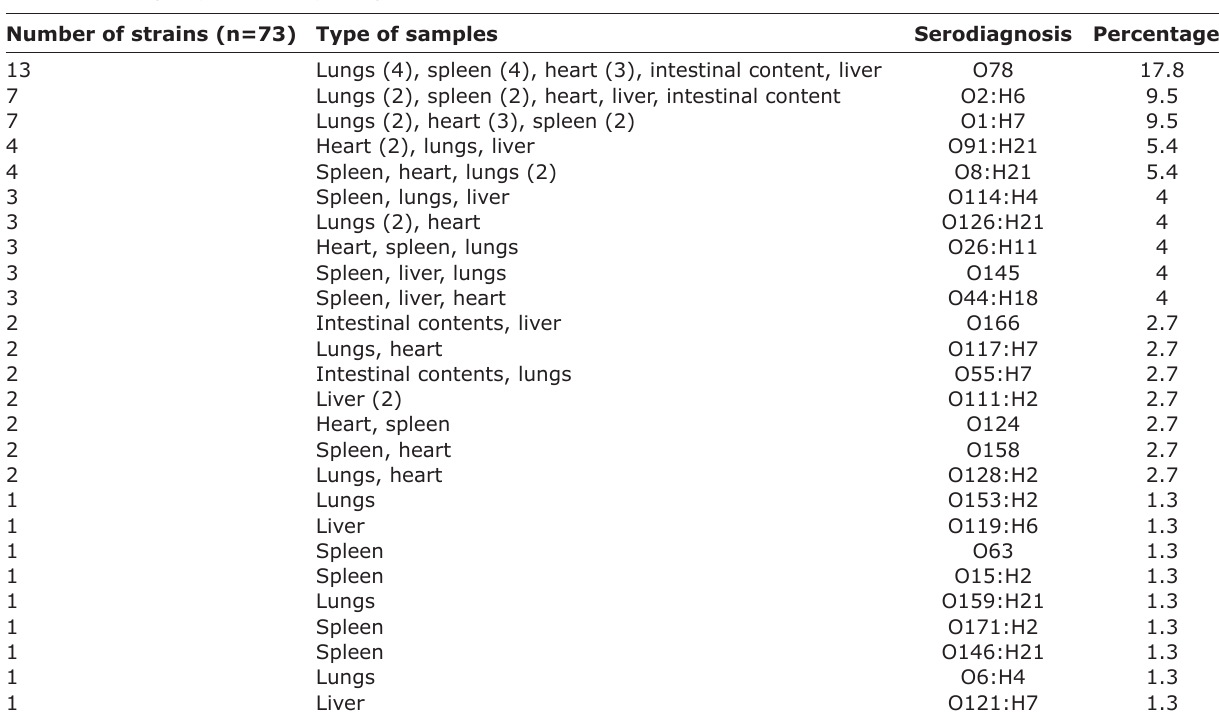
Table-2: Serogroups of avian pathogenic E. coli. Number of strains (n=73) Type of samples